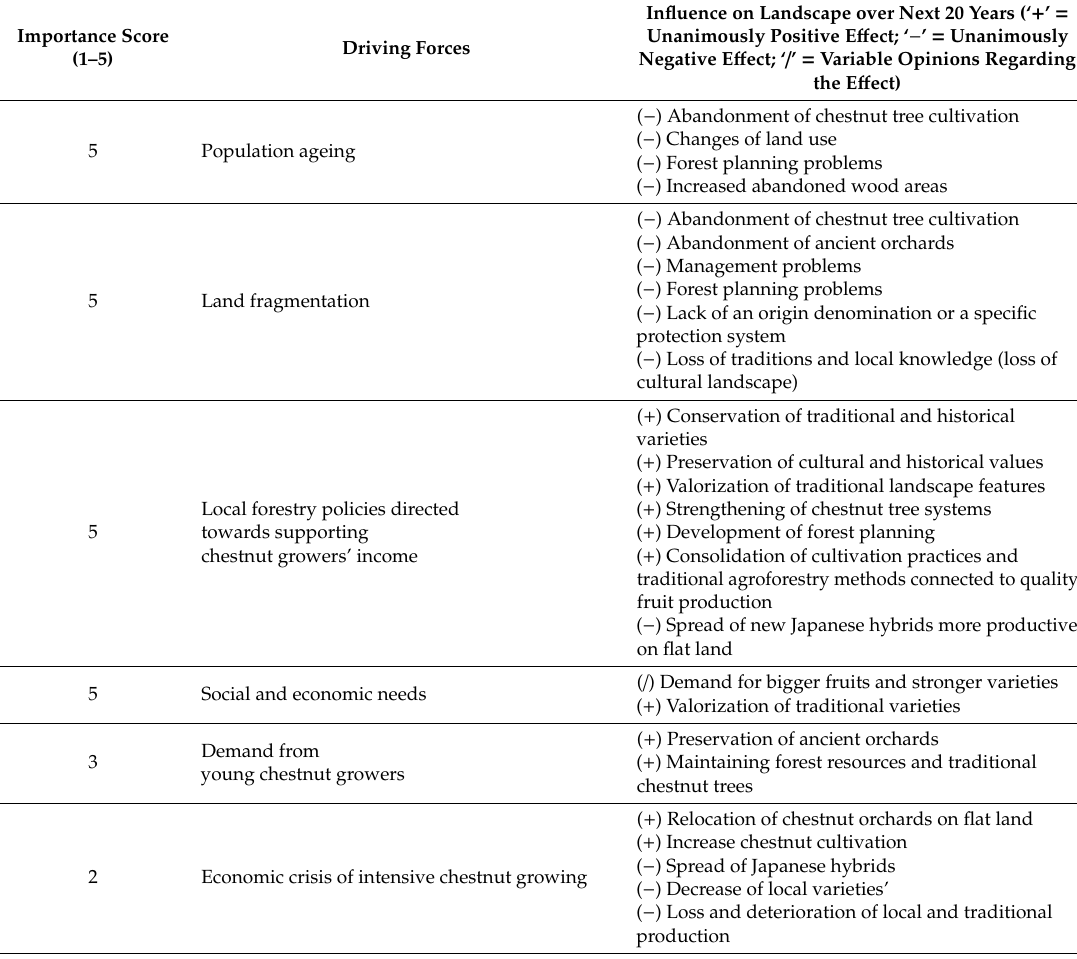
Table 2. Importance of driving forces identified by the participants of focus group and e ff ects on the traditional chestnut